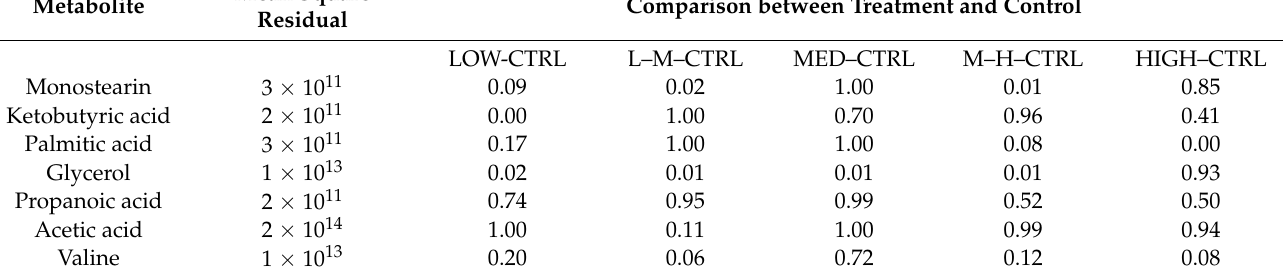
Table 2. Significantly changed metabolites following exposure to PFOS identified from a one-way ANOVA. Values in bold represent statistical significance following Tukey’s post hoc test. All values listed are BH-adjusted p values ( p < 0.05), using a 95% family-wise confidence level. Degrees of freedom =